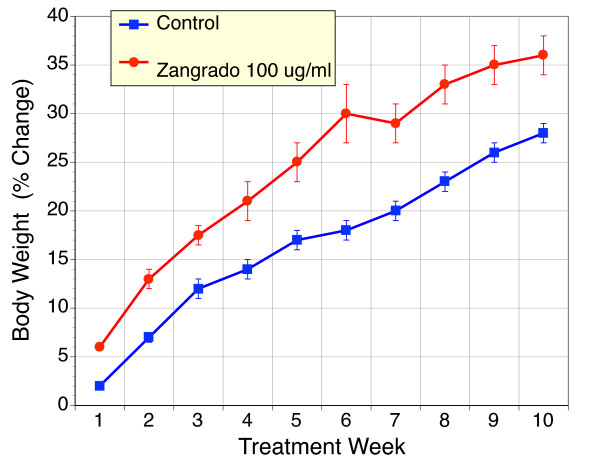
Body Weight in ApcMin/+mice over a 10 week treatment period with Zangrado or vehicle. Body weight (mean ± sem) of ApcMin/+mice determined over a 10 week treatment period is shown for mice treatment with Zangrado (n = 5, 100 μg/ml in drinking water) or unaltered drinking water (control). The Zangrado treated mice displayed a greater body weight over this period than did control mice (n = 10). This trend was not statistically significant.